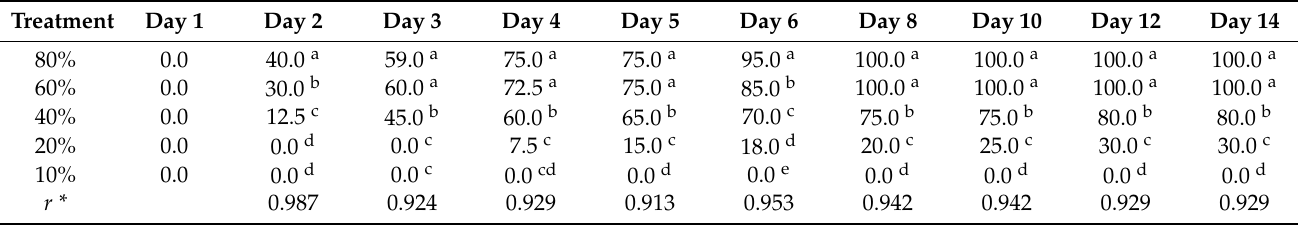
Table 1. Germination percentage of pea ( Pisum sativum L.) in response to soil water holding capacity levels: 80%, 60%, 40%, 20%, and 10% grown under continuous light at 25 ◦ C. Means followed by different letters are significantly different ( p ≤ 0.05) by LSD; r = correlation